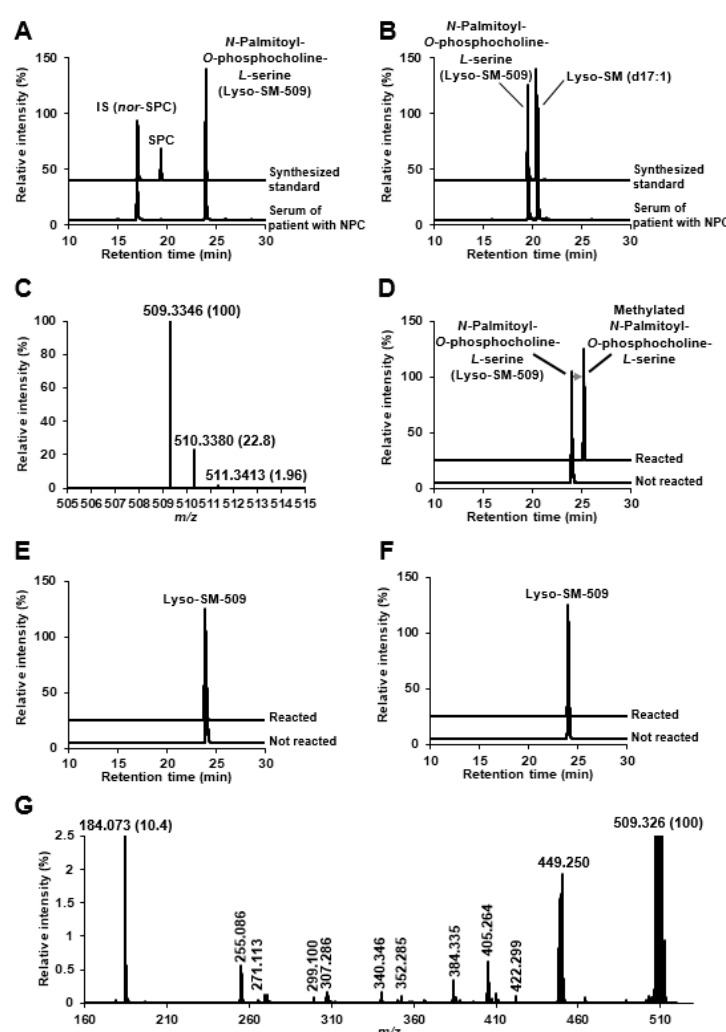
Figure 6. Graphs of Lyso-SM-509. ( A ) Reversed-phase mode chromatographic behavior of synthesized N -palmitoyl- O -phosphocholine-serine and serum Lyso-SM-509. ( B ) Hydrophilic interaction mode chromatographic behavior of synthesized N -palmitoyl- O -phosphocholine-serine and serum Lyso-SM-509. ( C ) Typical high-resolution mass spectrum of the synthesized N -palmitoyl- O -phosphocholine-serine. ( D ) Methyl esterification for N -palmitoyl- O -phosphocholine-serine. Upper, reacted N -palmitoyl- O -phosphocholine-serine; lower, N -palmitoyl- O -phosphocholine-serine. ( E ) Acetylation for N -palmitoyl- O -phosphocholine-serine. Upper, reacted N -palmitoyl- O -phosphocholine-serine; lower, N -palmitoyl- O -phosphocholine-serine. ( F ) NBD-derivatization for N -palmitoyl- O -phosphocholine-serine. Upper, reacted N -palmitoyl- O -phosphocholine-serine; lower, N -palmitoyl- O -phosphocholine-serine. ( G ) Typical hydrogen abstraction dissociation-product ion spectrum of N -palmitoyl- O -phosphocholine-serine. NBD, 7-nitro-2,1,3-benzoxadiazole.